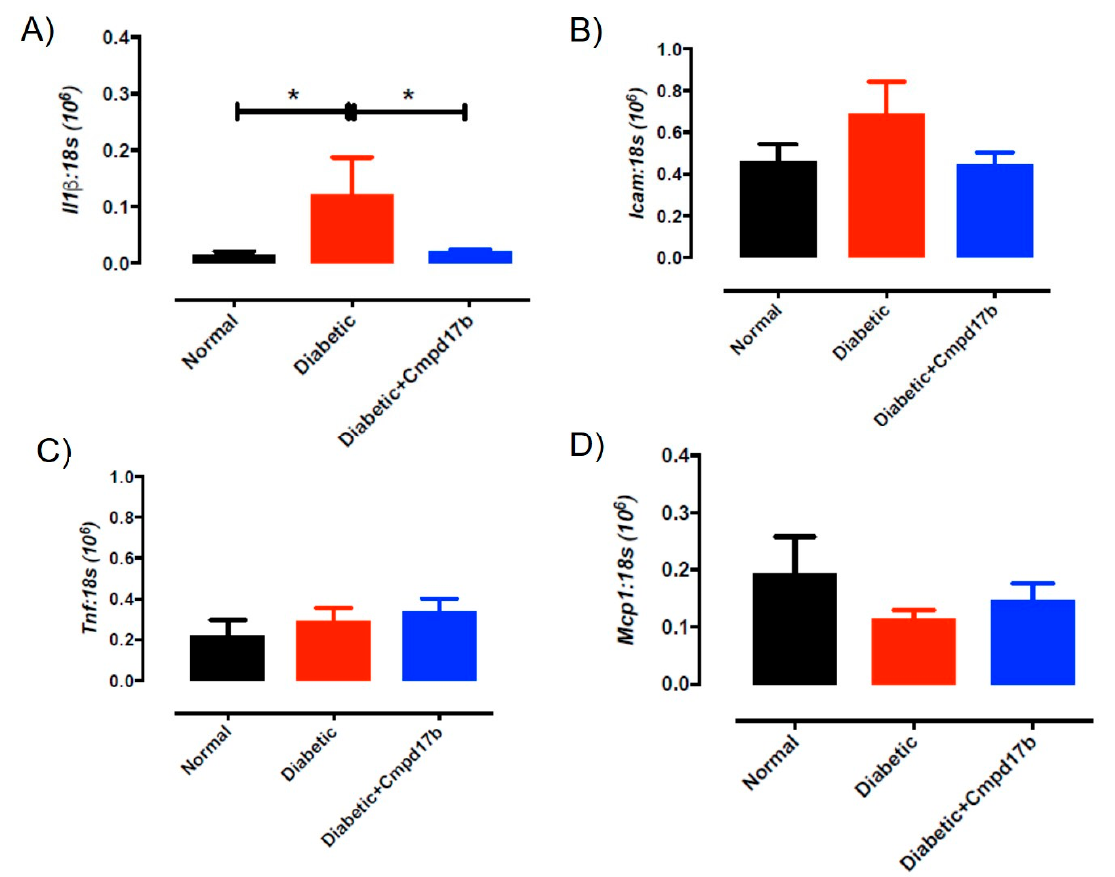
Figure 7. Quantitative PCR expression of ( A ) Il1 β , ( B ) Icam , ( C ) Tnf, and ( D ) Mcp1 mRNA in the aorta of citrate buffer (normal), or streptozotocin (diabetic)-treated male mice with or without Cmpd17b. Values are expressed as mean ± SEM, n = 6–12 per group. * P < 0.05 significantly different to diabetic mice.